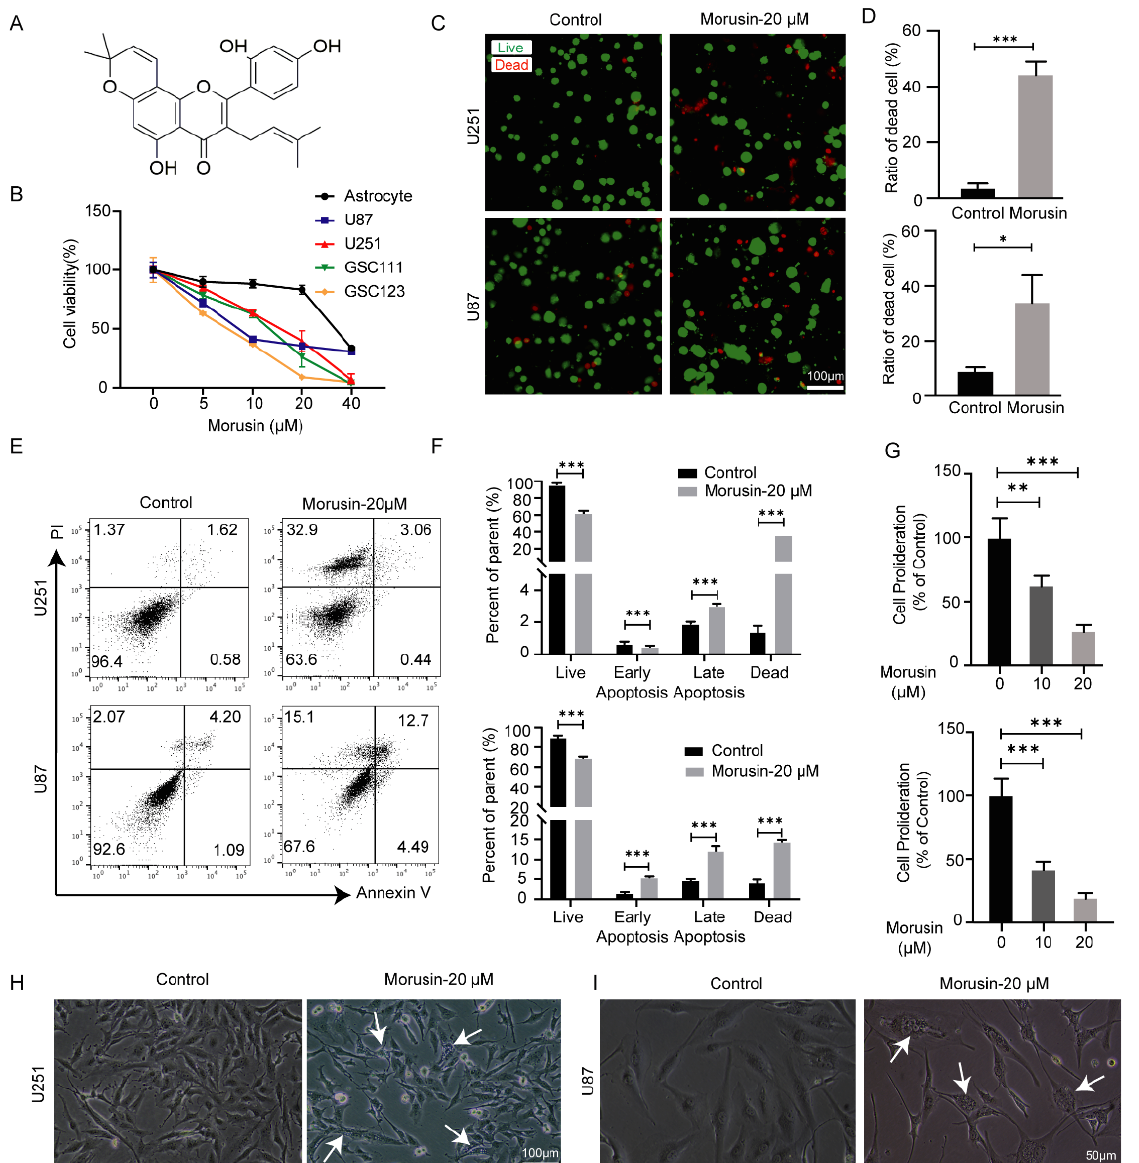
Figure 1. Morusin suppressed the cell viability and induced the apoptosis of GBM cells. ( A ) The structure of morusin. ( B ) Cell viabilities of GBM cells, GSC cells and normal human astrocytes after different concentrations of morusin exposure for 24 h. The results were calculated relative to the control group. ( C ) Representative images of live (green)/dead (red) fluorescent staining of U251 and U87 cells after morusin treatment (20 µ M, 24 h). Bar = 100 µ m ( D ) Quantification of cell death following live/dead fluorescent staining. ( E ) Annexin V/PI staining of morusin-treated GBM cells. Cells were exposed to morusin for 24 h. ( F ) Quantification of apoptotic cells following annexin V/PI staining. ( G ) Effects of morusin on U251 and U87 cell proliferation as assessed by cell counting assay. ( H , I ) Phase-contrast microscope showing morphological changes of U251 and U87 cells after treatment with 20 µM of morusin for 12 h. Bar = 100 µm. The data represent the mean ± SEM ( n ≥ 3). * p < 0.05, ** p < 0.01, *** p < 0.0001 compared to indicated comparator. The cytotoxicity of morusin to U87 and U251 cells was also confirmed by live/dead assay and annexin-V/PI staining assay. After morusin treatment for 24 h, the proportions of dead cells among both U87 and U251 cells were strikingly elevated (Figure 1C,D). The proportions of apoptotic cells (annexin V+) and dead cells (PI+) were increased by morusin, and the percentage of double negative live cells was decreased (Figure